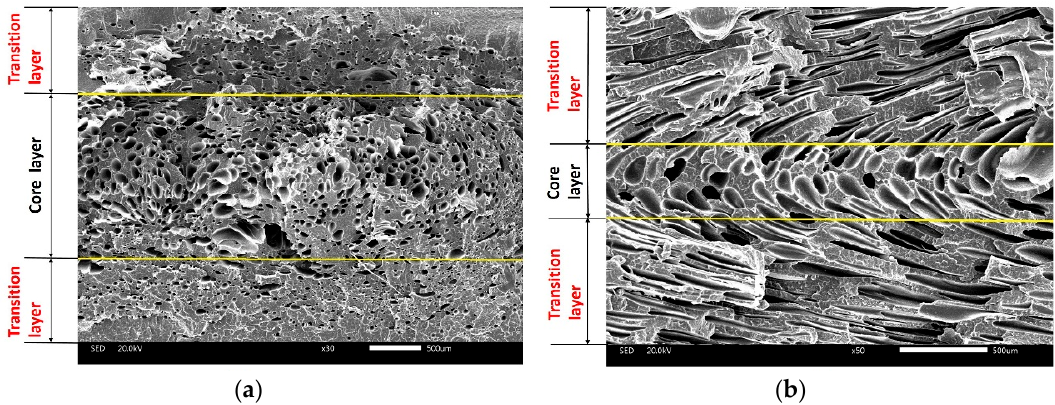
Figure 9. The distribution of cells of ( a ) vertical and ( b ) parallel sections.